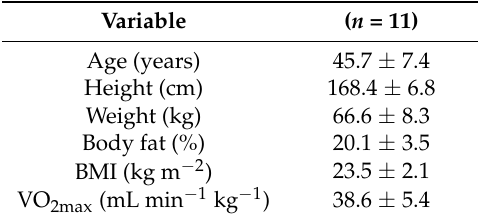
Figure 1. Selection flowchart of participants. HIIT: High-intensity interval training; MICT: Moderate- intensity continuous training; VICT: Vigorous-intensity continuous training. Table 1. Demographic characteristics of the participants.